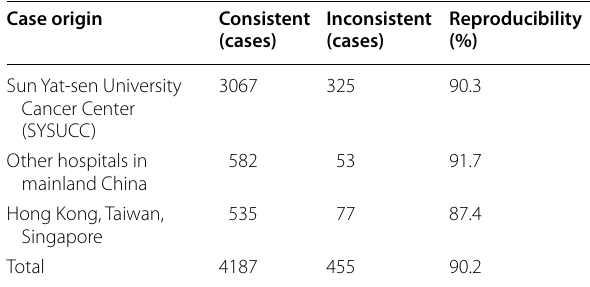
Table 3 Clinical characteristics of NPC patients in the training, retrospective validation, and prospective valida- tion